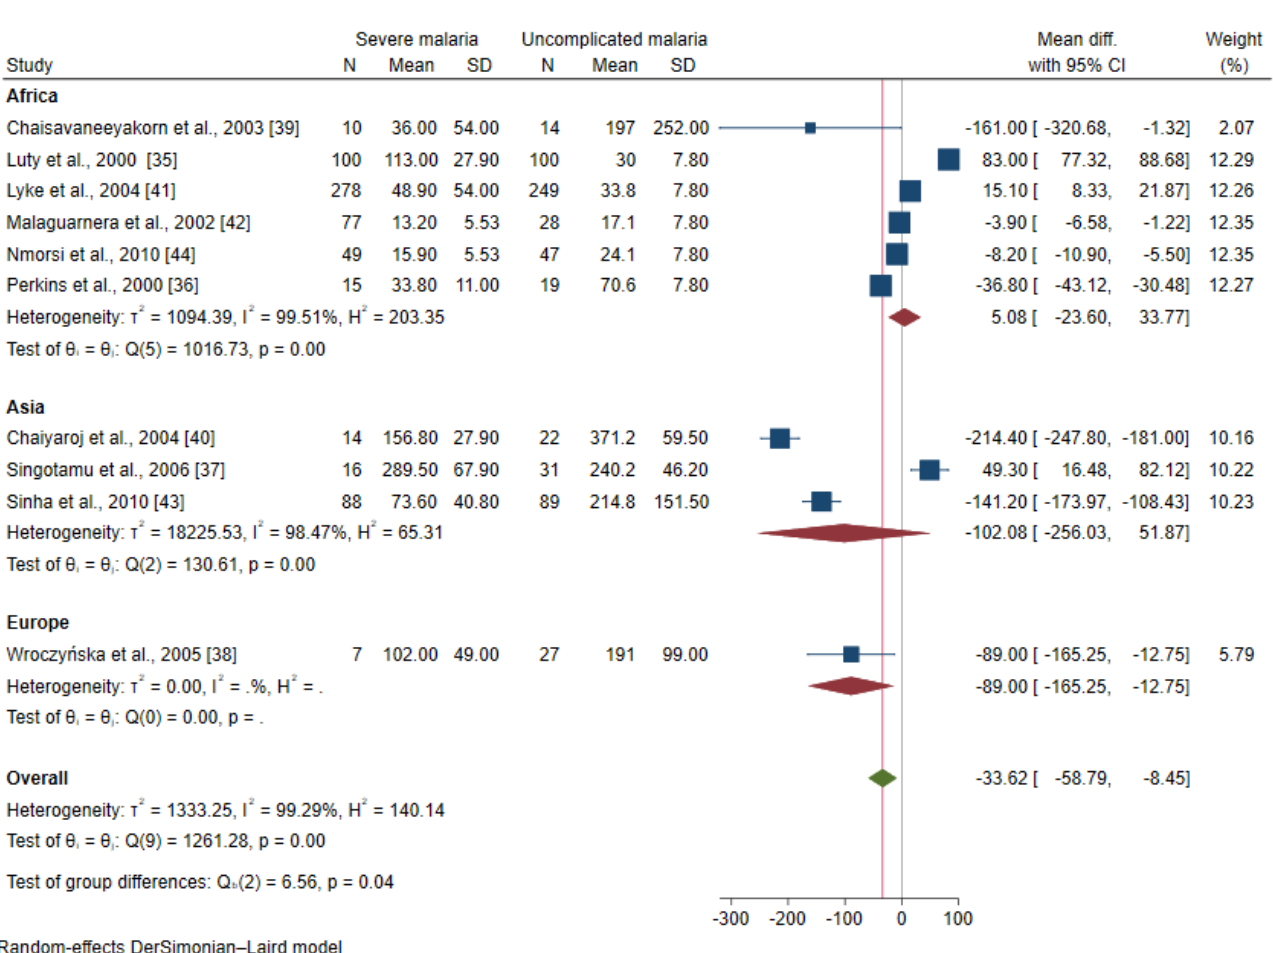
Figure 3. Forrest plot demonstrated the difference in the mean IL-12 levels (pg/mL) between patients with severe malaria and uncomplicated malaria stratified by continents [35–44]. Abbreviation: Mean Diff., mean difference; CI, confidence interval. Explanation of the forest plot: squared-box symbol, point estimate; green diamond and red line: pooled mean difference: red diamond: pooled mean difference in each subgroup; blue line: line of no effect; I 2 , level of heterogeneity; p = 0.00 or less than 0.05, significant heterogeneity.